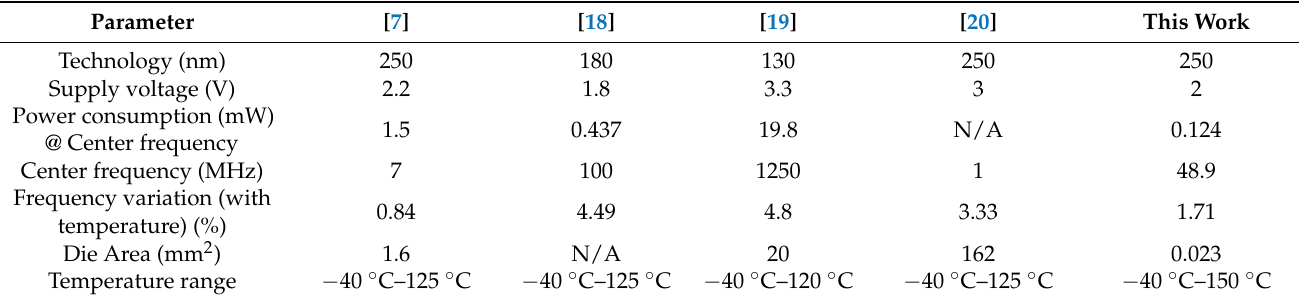
Table 5. Comparison results with previously reported